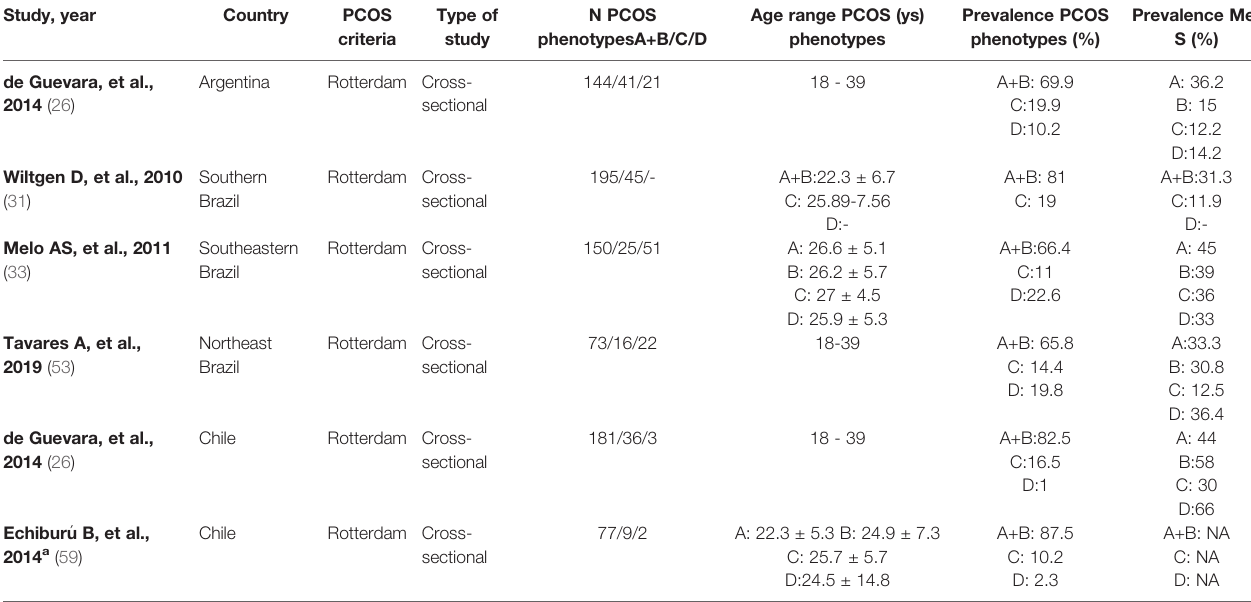
TABLE 3 | Prevalence of PCOS phenotypes and of Metabolic syndrome in the studies included in the systematic review. Study,